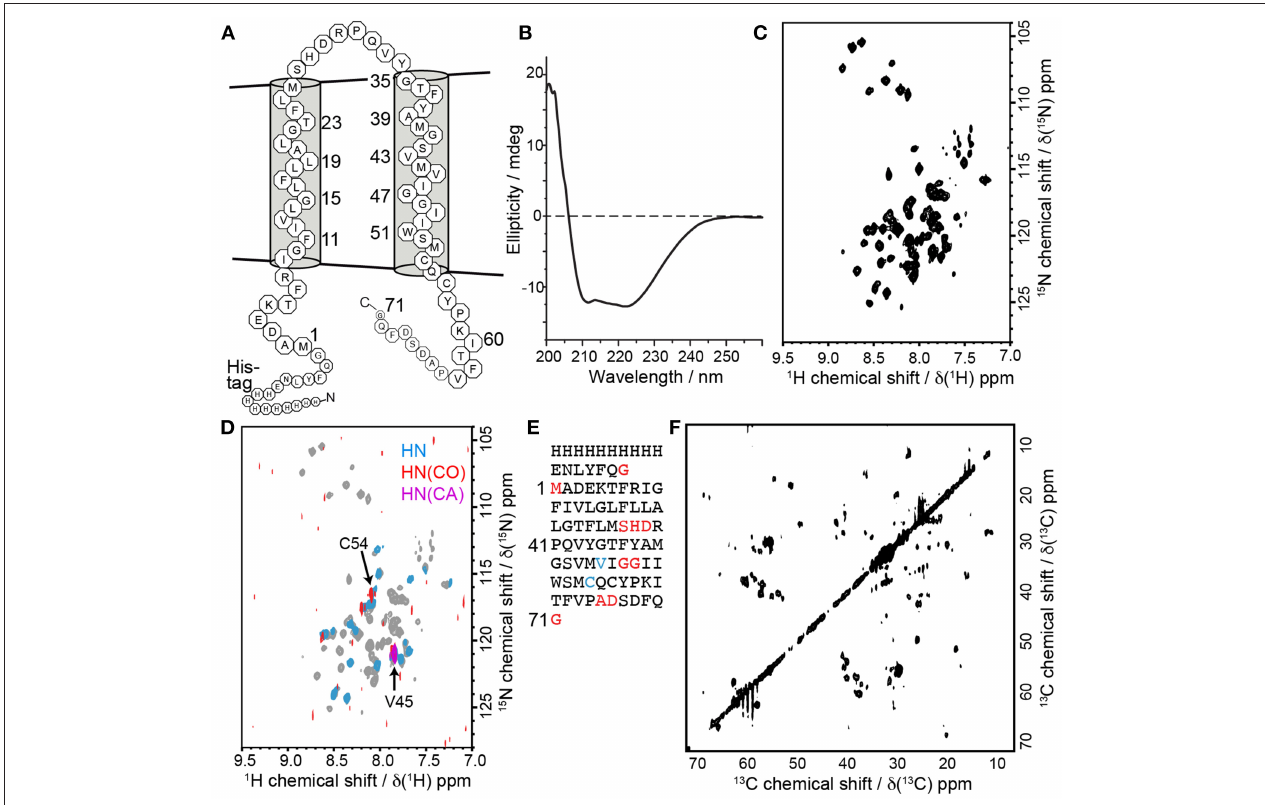
FIGURE 5 | Barttin in LDAO micelles. (A) Expected topology model of barttin according to (Wojciechowski et al., 2015). (B) Circular dichroism spectrum of barttin in LDAO micelles. (C) [ 15 N- 1 H]-HSQC spectrum of [U- 2 H- 13 C- 15 N]-labeled barttin in LDAO micelles (Cys, Asn and Trp are unlabeled). (D) Overlay of [ 15 N- 1 H]-HSQC acquired on [ 2 H- 13 C- 15 N]-labeled barttin in LDAO micelles (gray) and on a selectively labeled sample (see methods for labeling pattern, blue). In addition, the [ 15 N- 1 H] dimension of a HNCO (red) and of a HNCA (purple) are shown. The labeling pattern directly allows assignments of indicated residues. (E) Primary sequence of the used barttin construct highlighting residues with assigned resonance frequencies from conventional 3D experiments (red) and using selective isotope labeling (blue). (F) 2D 13 C- 13 C FLOPSY spectrum acquired using an UTOPIA NMR setup ( Viegas et al.,